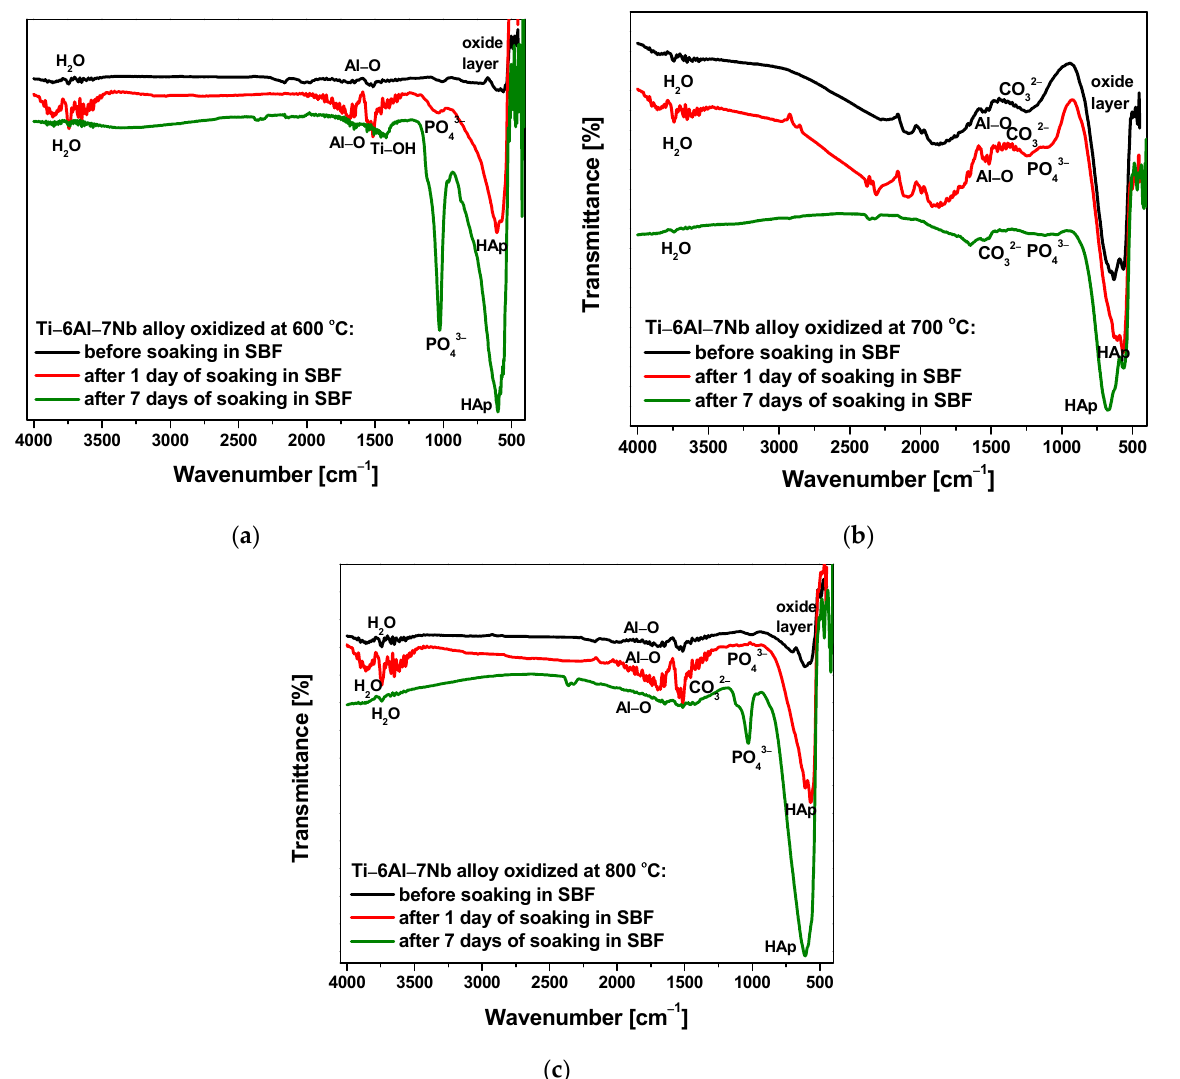
Figure 14. ATR ‐ FTIR spectra of the alkali ‐ treated Ti ‐ 6Al ‐ 7Nb alloy after soaking in SBF at 36.6 °C for 24 h: ( a ) Oxidized at Figure 14. ATR-FTIR spectra of the alkali-treated Ti-6Al-7Nb alloy after soaking in SBF at 36.6 ◦ C for 24 h: ( a ) Oxidized at 600 °C; ( b ) Oxidized at 700 °C; ( c ) Oxidized at 800 °C. 600 ◦ C; ( b ) Oxidized at 700 ◦ C; ( c ) Oxidized at 800 ◦